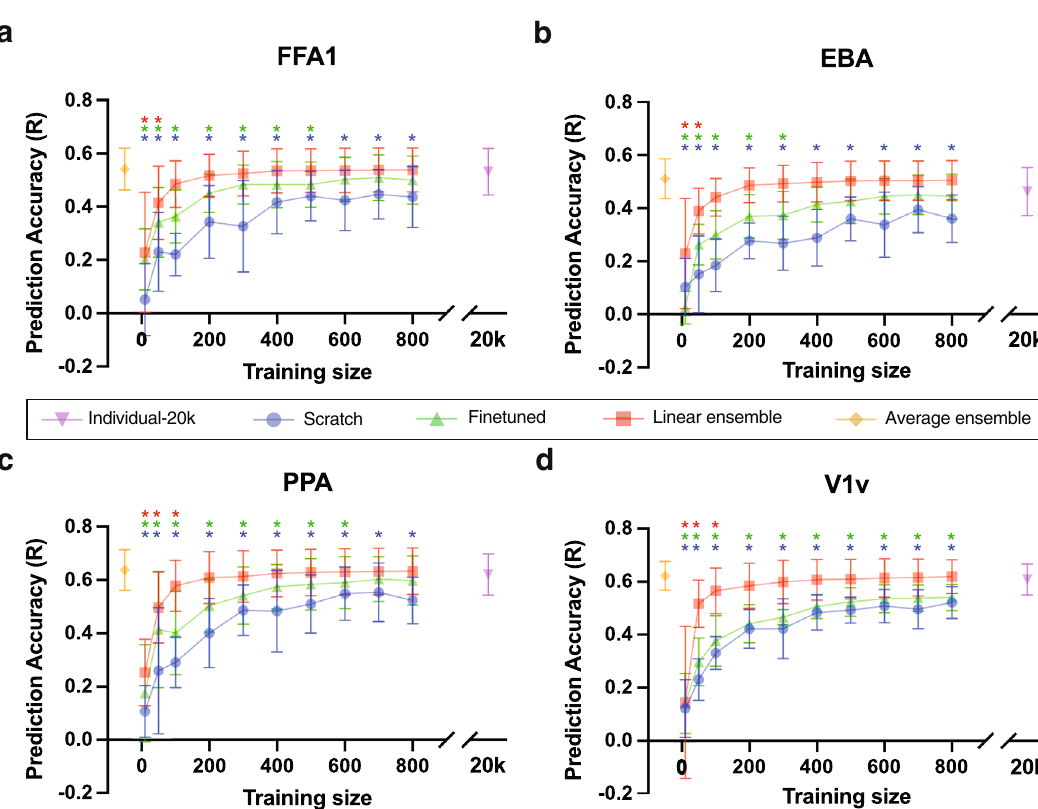
Fig. 2 Encoding model accuracies for FFA1, EBA, PPA and V1v regions, by the size of the training dataset (x-axis). a – d Boxplots indicate encoding model test accuracy across 8 NSD subjects for the scratch (blue), fi netuned (green) and linear ensemble (red) models as training size increases from 10 to 800 image-response pairs. Individual-20K model accuracy is illustrated via the purple boxplot (training size of 20K) and the average ensemble model accuracy is illustrated via the orange boxplot (training size of 0). Asterisks, colored according to the model in question, indicate a signi fi cant difference (Wilcoxon tests, p < 0.05) in those models from the gold-standard individual-20K